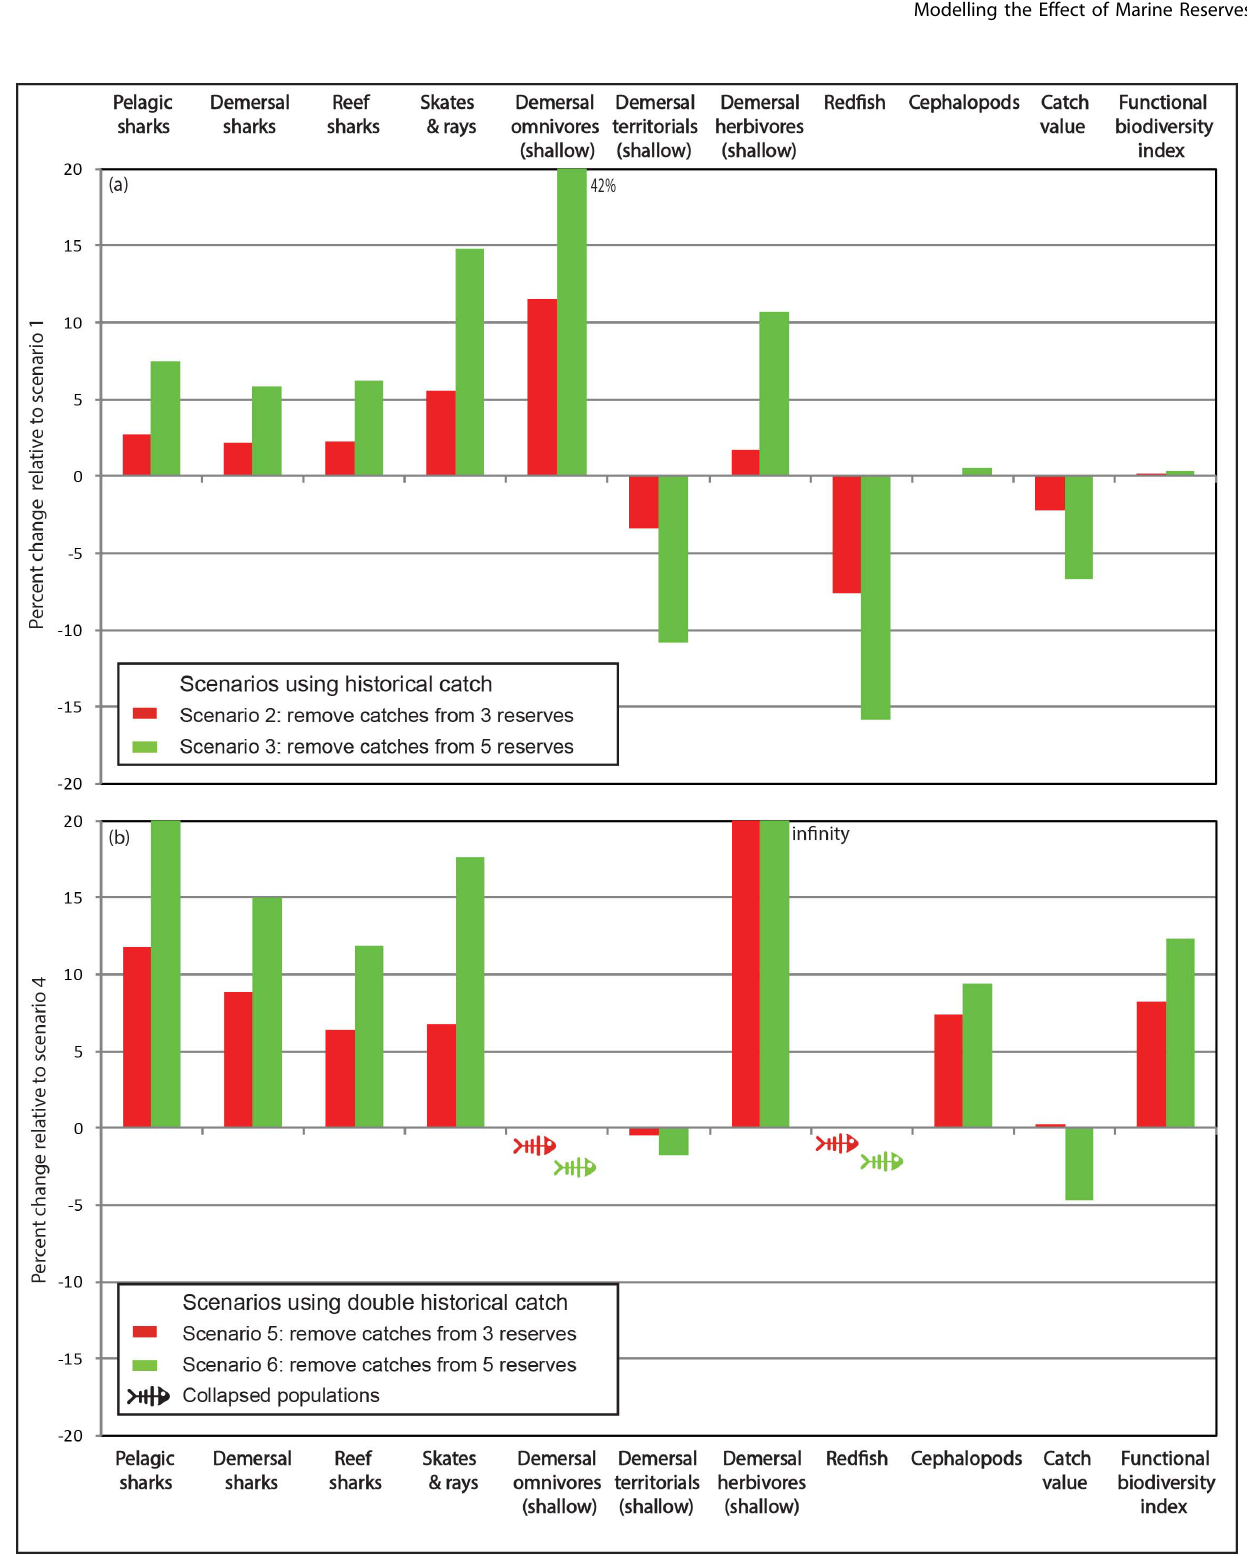
Figure 3. Percentage final biomass changes over 30 years (a) for scenarios 2 and 3 relative to scenario 1 (i.e. low fishing scenarios) (b) for scenarios 5 and 6 relative to scenario 4 (i.e. high fishing scenarios). for the nine functional groups that showed a decrease/ increase of more than 8% in at least one of the scenarios. Relative fishery catch value and the biodiversity index are also shown.